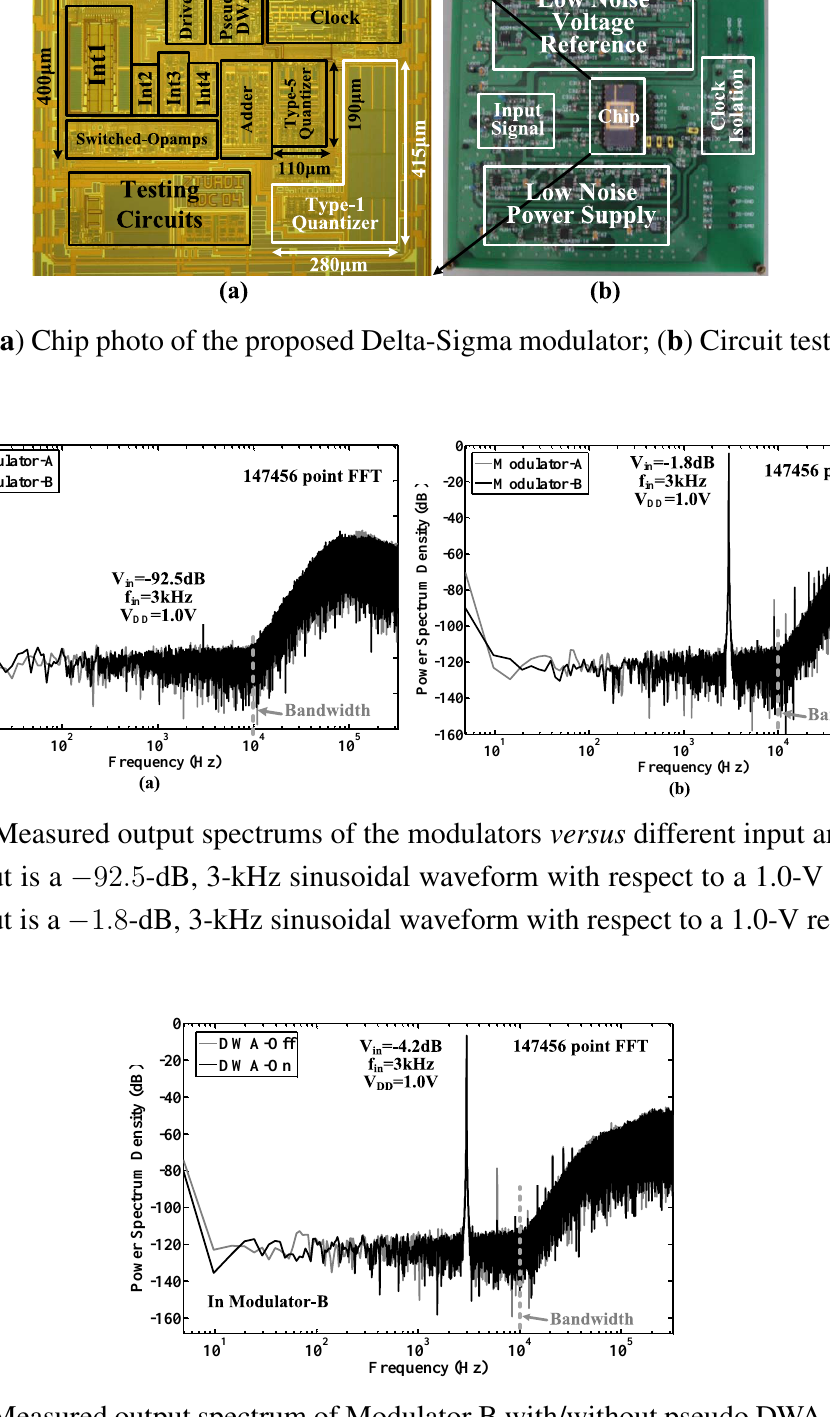
Figure 17. Measured output spectrum of Modulator B with/without pseudo DWA. The input is a − 4 . 2 -dB, 3-kHz sinusoidal waveform with respect to a 1.0-V